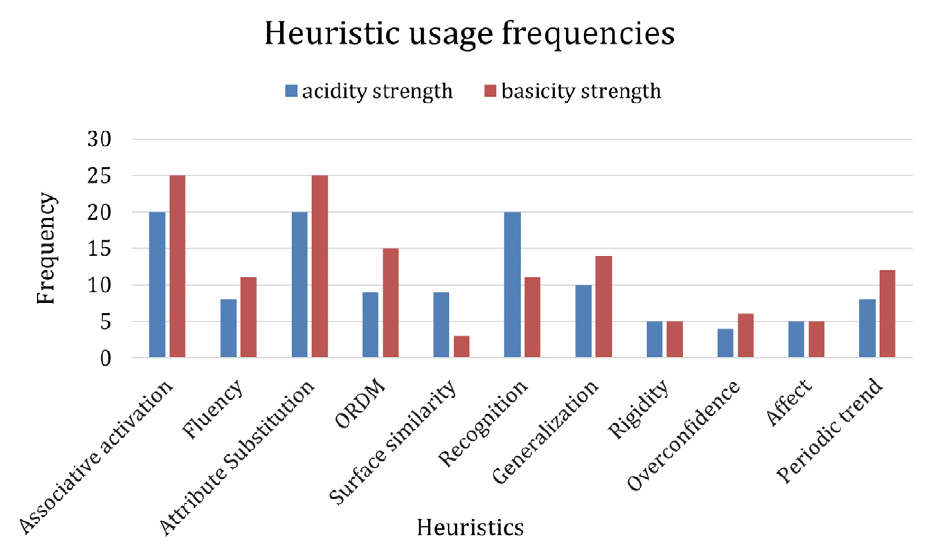
Figure 1. Graphical presentation of heuristic usage frequencies In the study conducted by Maeyer and Talanquer 40 on the ranking of HCl, H 2 S and HI compounds according to their increasing acidity strength and KOH, Mg(OH) 2 and Ca(OH) 2 compounds according to their increasing ba- sicity strength, the accuracy rate of student answers to